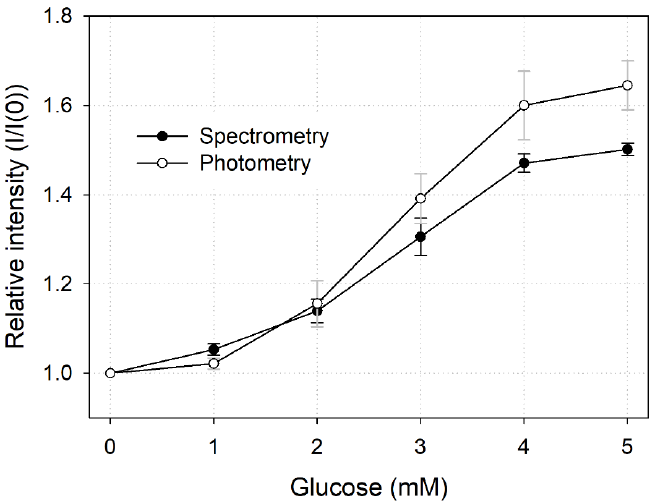
Figure 7. Comparison of spectral and photometric glucose quantification methods.